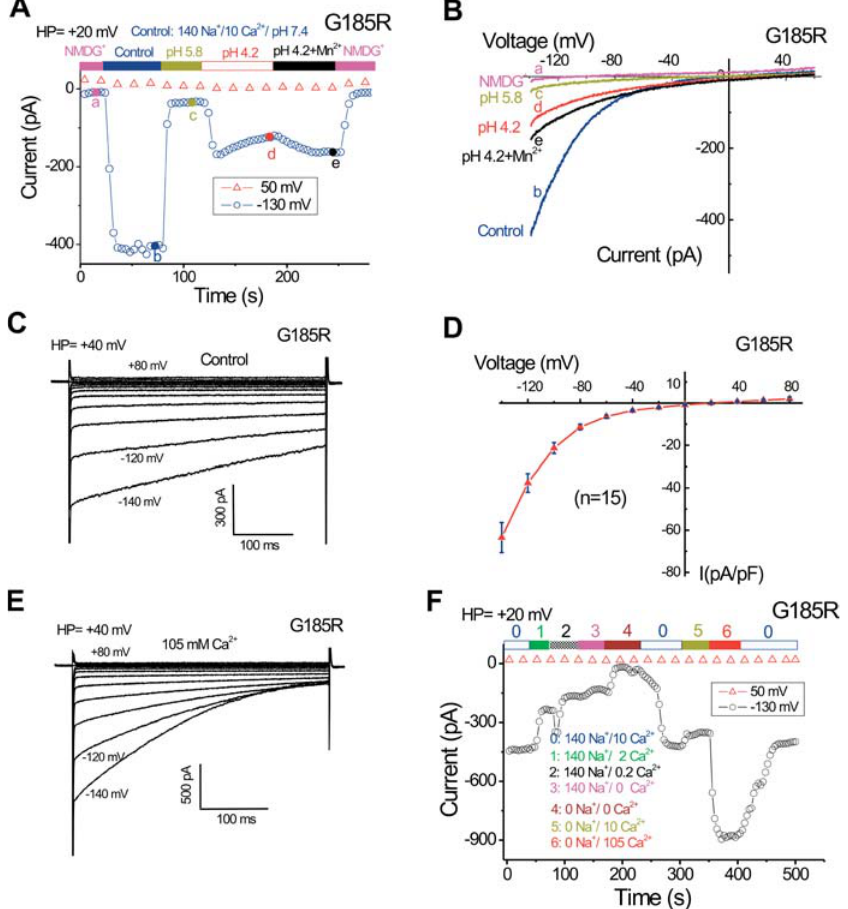
Figure 2. G185R-Expressing Cells Display a Constitutive [Ca 2 þ ] o -Dependent Cationic Current (A–B) Large inward currents were evoked by control solution (10mM Ca 2 þ / 140 mM Na þ [pH 7.4]) in G185R-trans- fected cells. The current was inhibited